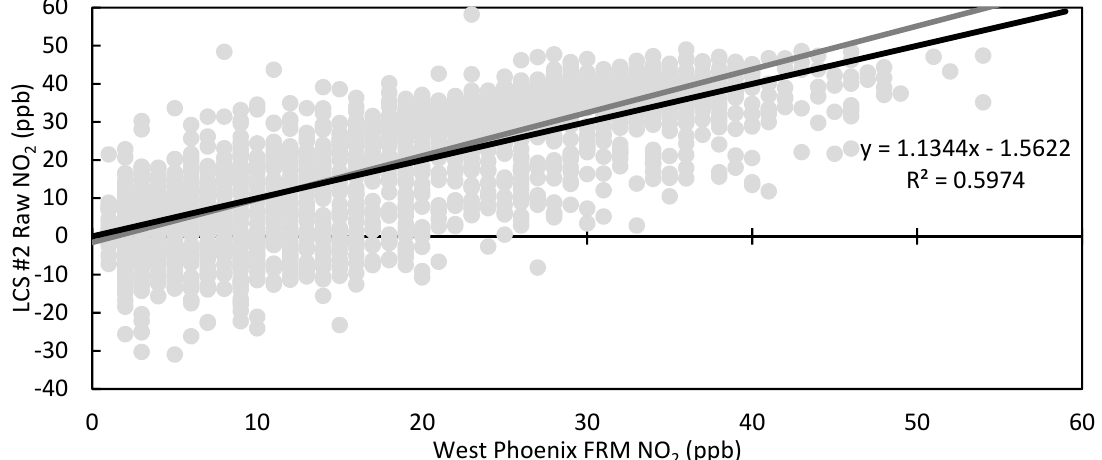
Figure 4. Scatter plot of hourly LCS #2 Raw NO 2 vs. West Phoenix FRM NO 2 with trendline equation and R 2 , 1:1 line in black. Table 2. Data summary for the raw data from the 8 LCSs collocated at West Phoenix over the entire deployment period, calculated using West Phoenix FRM NO 2 data.